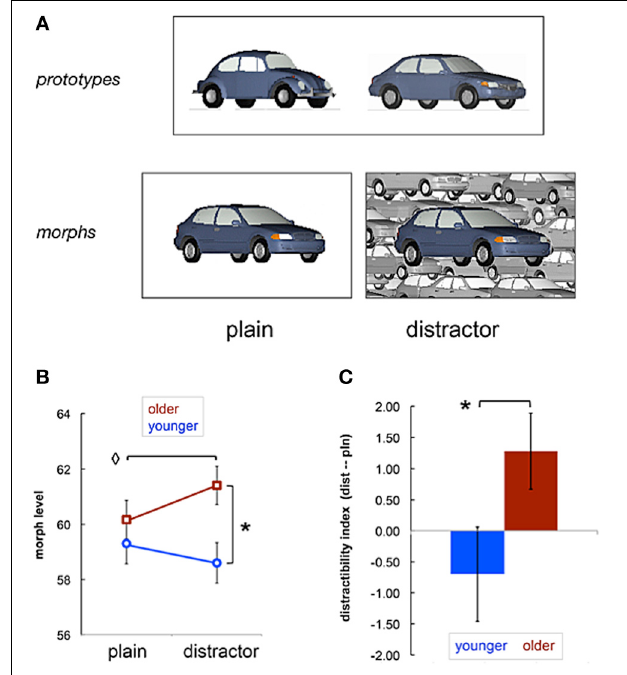
FIGURE 5 | Age-related influence of visual distraction on categorization learning. The categorization procedure (A) presented a side-by-side pair of category prototypes, and then an exemplar morphed from the prototypes in blocks of either plain or distractor conditions. Results (B) for mean categorization thresholds for groups of older and younger adults showed a main effect of age and suggested that categorization learning declined for older adults in the distractor, relative to plain conditions. Comparisons between age groups for an index of distractibility (C) revealed that older adults were more susceptible to the negative impact of distraction during categorization than younger adults ( p < 0 . 05). Error bars indicate the standard error of the mean; ♦ indicates a trend of difference between means, p < 0 . 06; and ∗ indicates a difference between means, p < 0 .